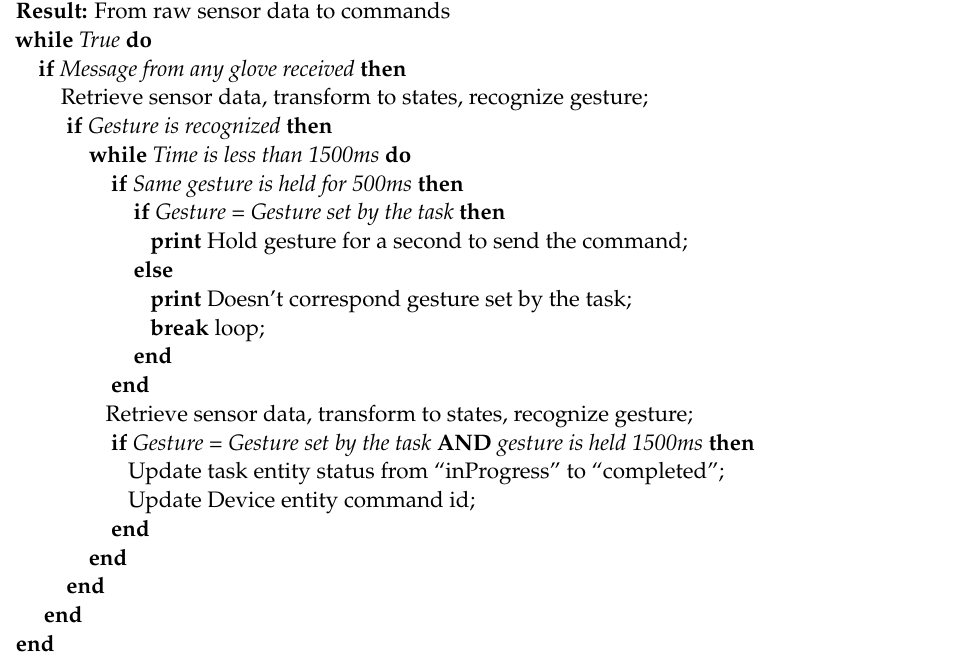
Algorithm 1: How Application Controller transforms raw sensor data to